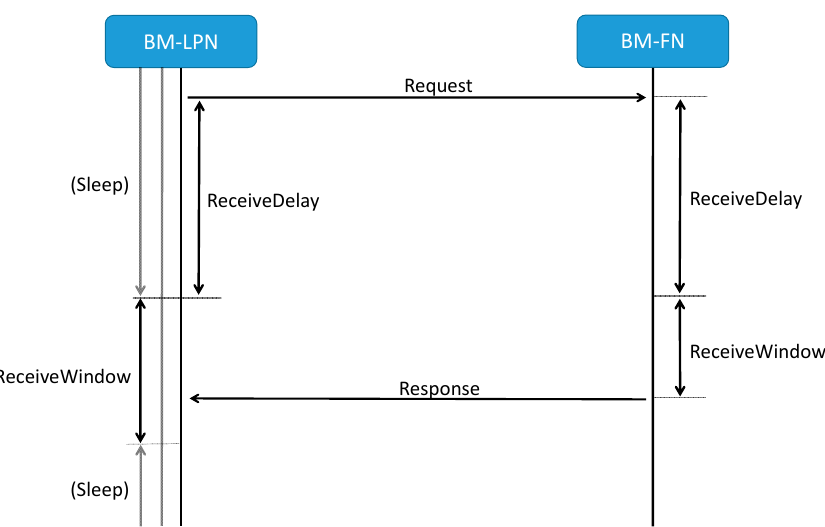
Figure 3. Illustration of a BM-LPN polling a BM-FN, and the related Bluetooth Mesh parameters involved.